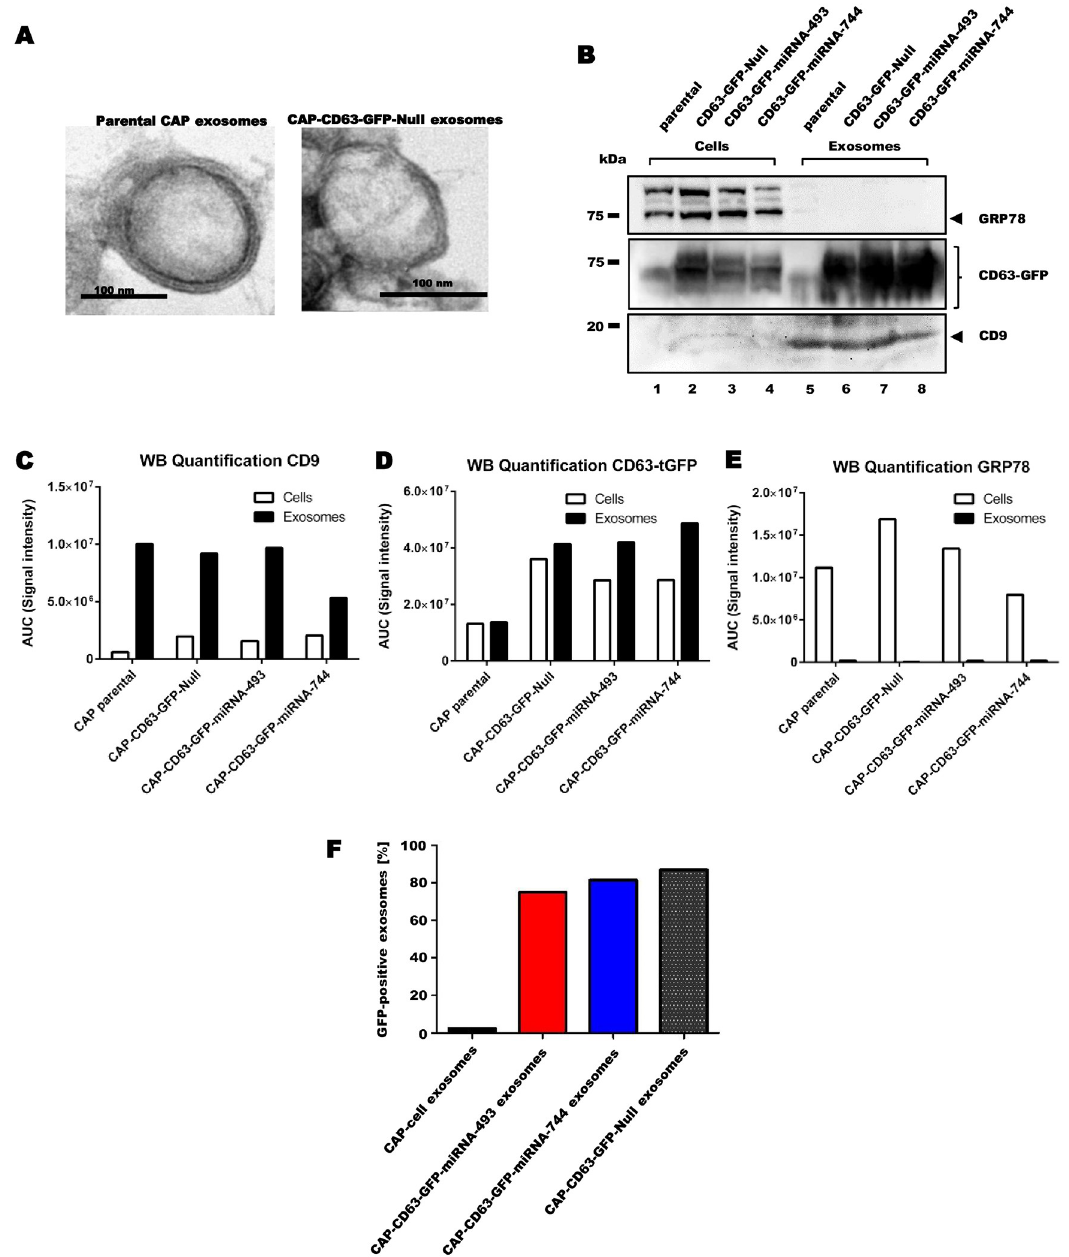
Fig 1. Morphological and biochemical analysis of isolated CAP exosomes. ( A ) Transmission electron microscopy pictures of parental (left) and modified (right) CAP exsomes. Scale bar represents 100 nm. ( B ) Western blot of 30 μ g cellular and exosomal protein lysates per lane. Blotting performed on GRP78 (upper panel), turbo-GFP (middle panel) and CD9 protein (lower panel). Lane 1–4 represent cellular lysates, while lanes 5–8 depict exosomal lysate. ( C ) Quantification of Western blot Fig 1 B for CD9 signal. ( D ) Quantification of Western blot Fig 1 B for tGFP signal. ( E ) Quantification of Western blot Fig 1 B for GRP78 signal. ( F ) Flow cytometry analysis of GFP-positive exosomes isolated from parental and modified CAP cells.